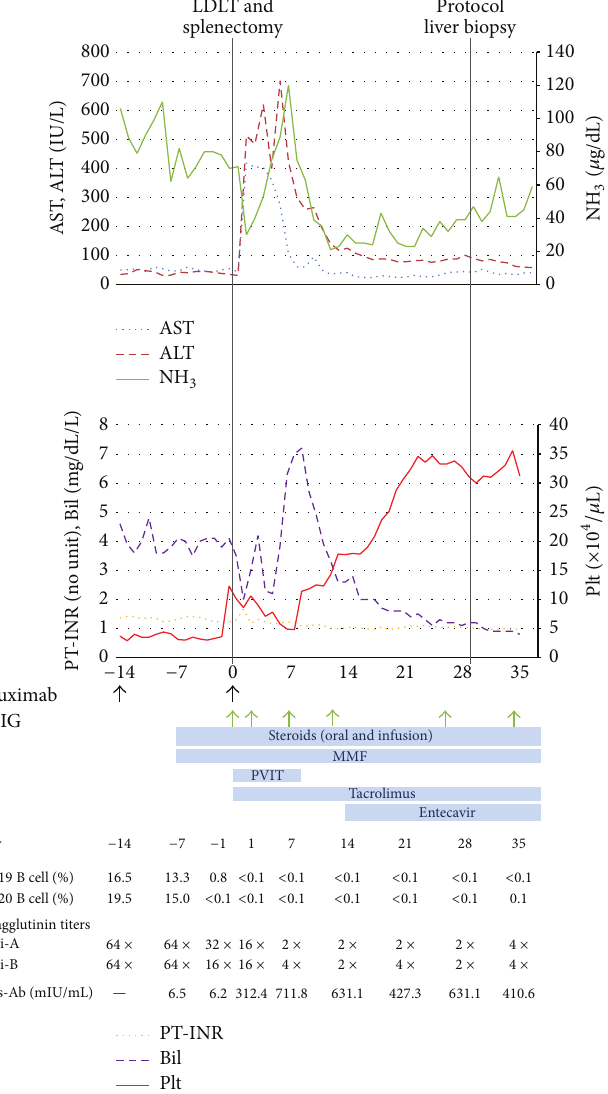
Figure 1: Major treatments, events, and laboratory results in the clinical course. Panel shows a timeline of the recipient’s clinical course until discharge, with arrows indicating points of administration of rituximab and HBIG. Periods of steroids, MMF, PVIT, tacrolimus, and entecavir are indicated by the gray bars. Results of CD19- and CD20-positive B cell count, isoagglutinin titers of anti-A and anti-B, and HBs-Ab are shown below the